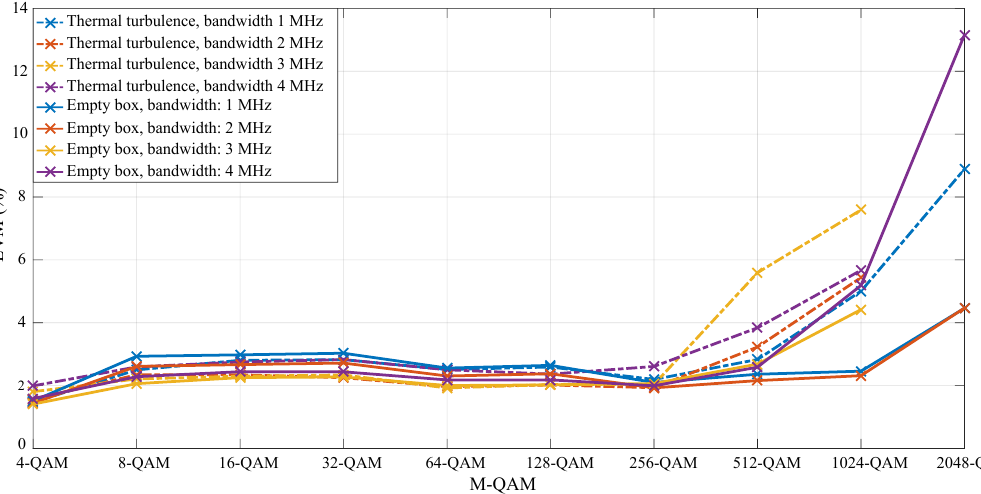
Figure 21. EVM/distance relationship for Octavia tail-light with different M-QAM and bandwidths—scenario 2—thermal turbulence.